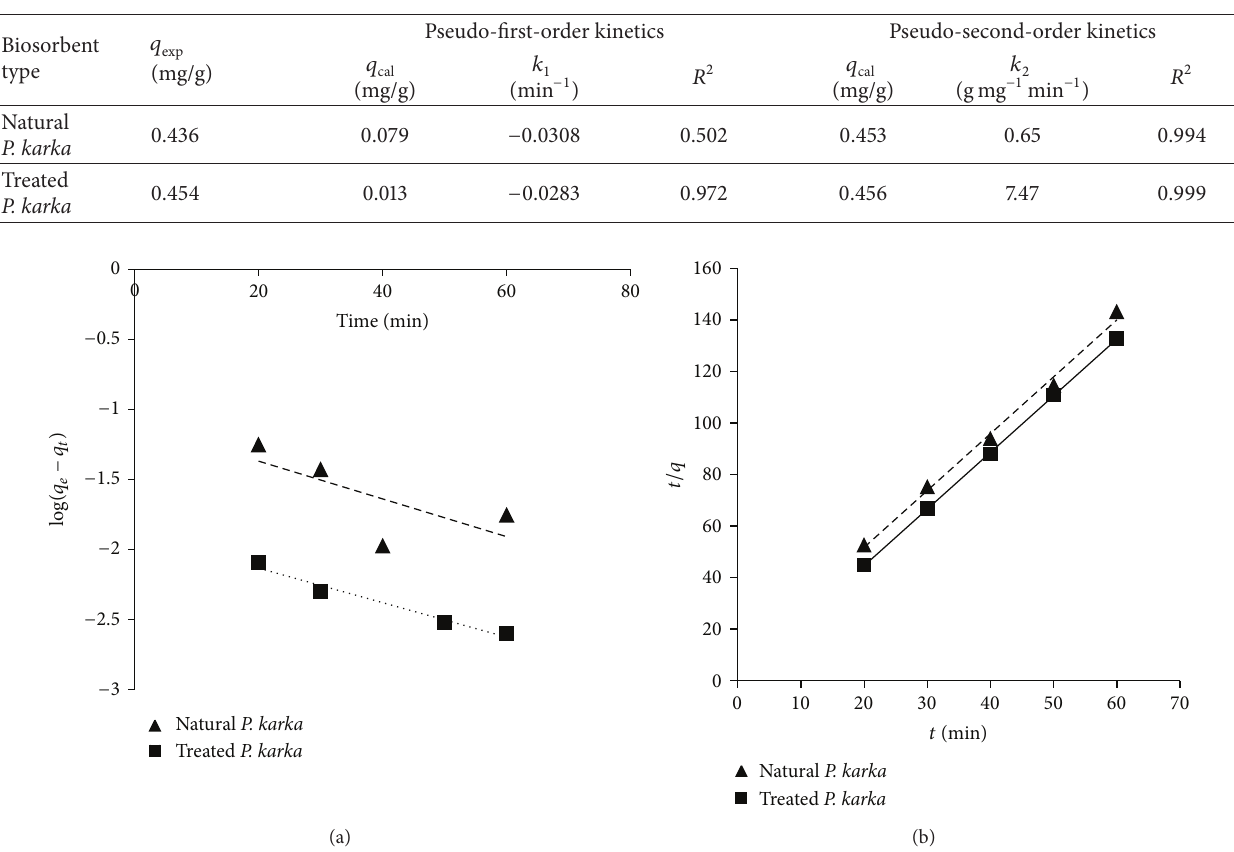
Table 1: Parameters of pseudo-first-order and pseudo-second-order kinetic models for the biosorption of mercury ions on the surface of natural P. karka and treated P. karka .